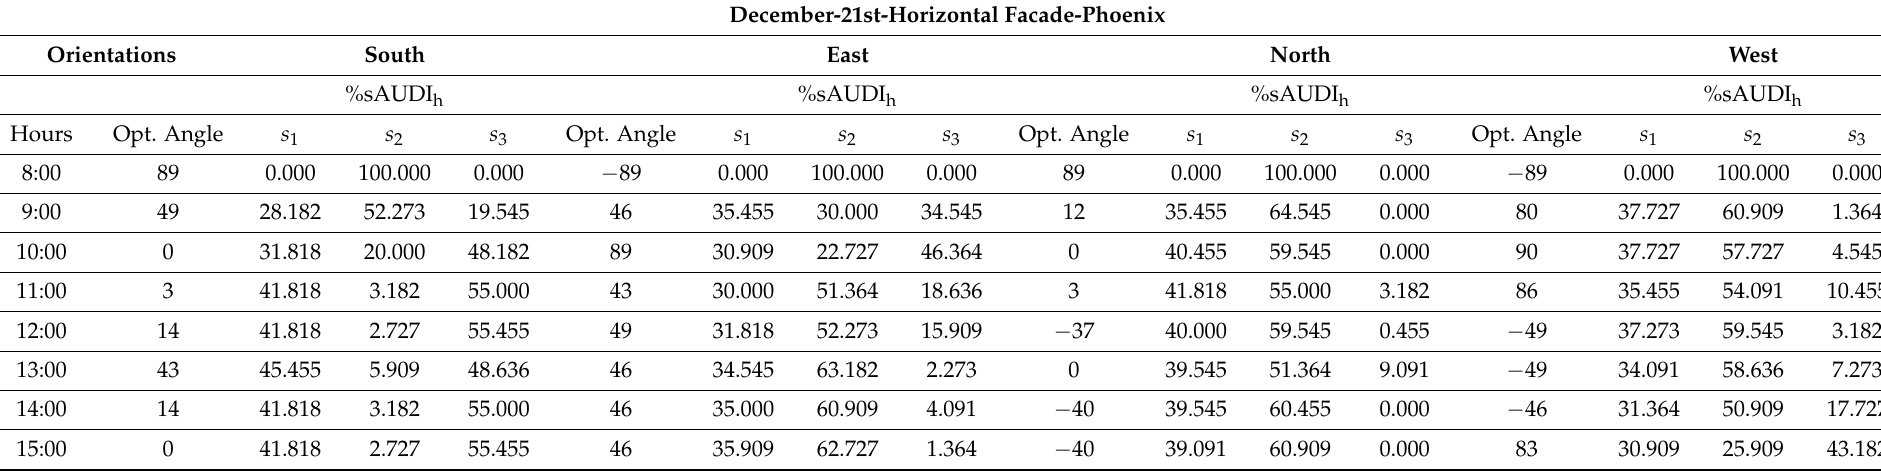
Table 4. Hourly optimum angles and the associated sAUDI h for three different human activities of s 1 , s 2 , and s 3 and four facade orientations calculated for 21 December-Phoenix-Horizontal